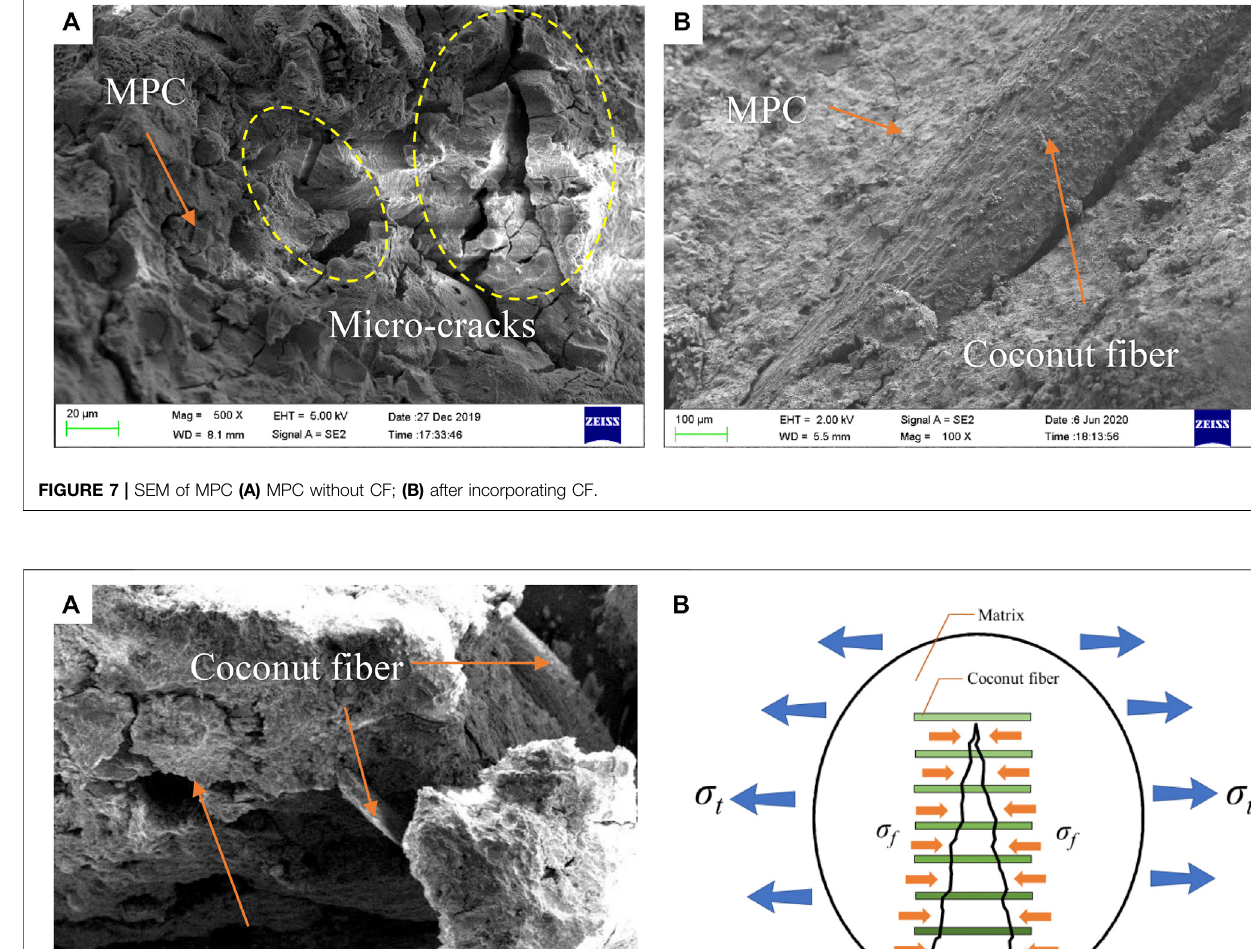
Frontiers in Materials |